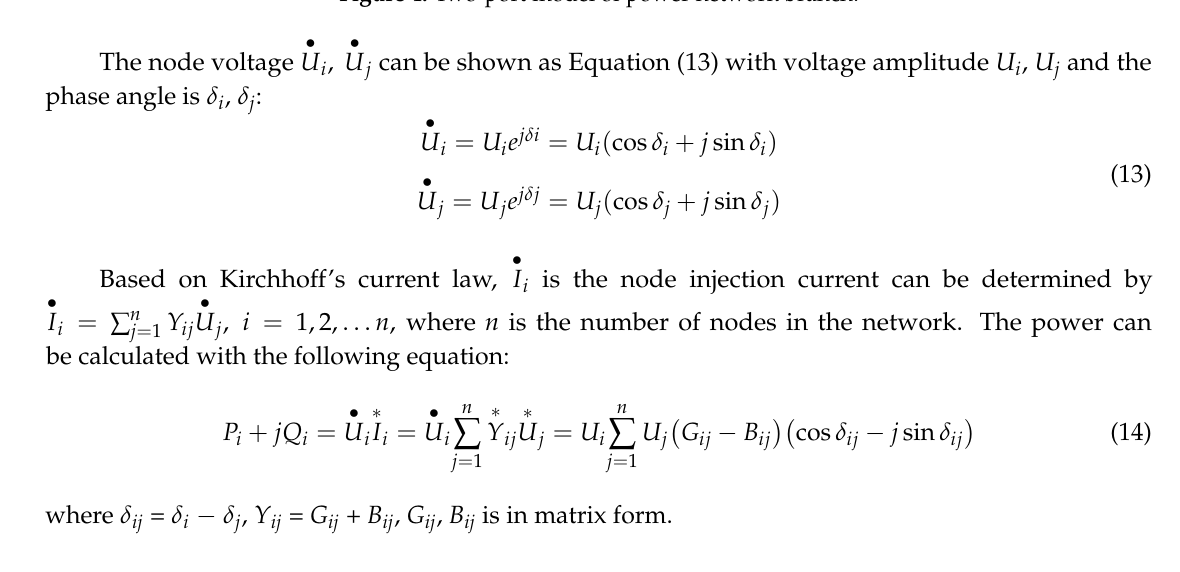
Figure 4. Two-port model of power network branch.